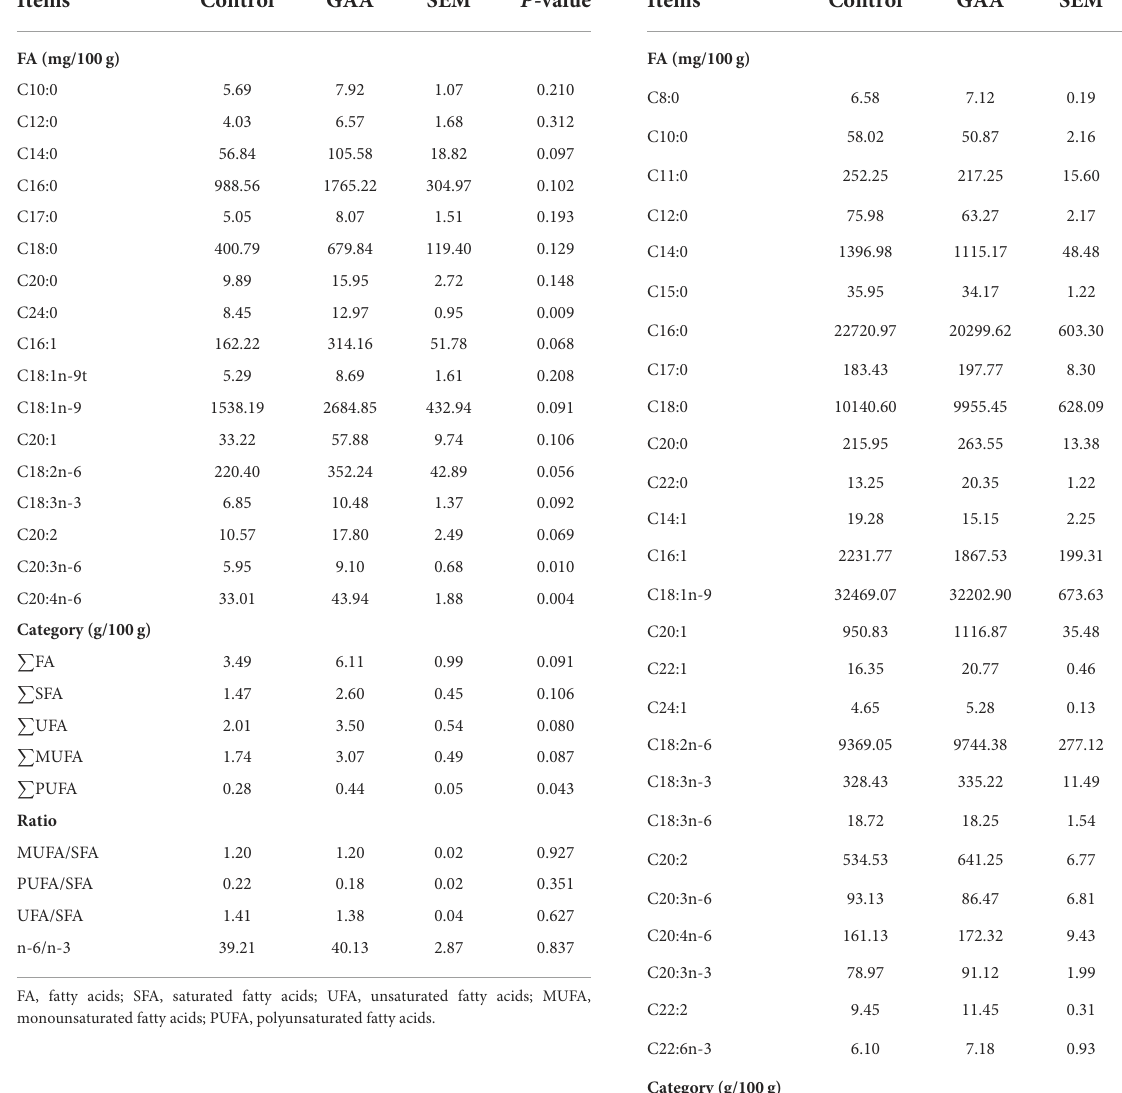
TABLE 6 Effect of dietary GAA on fatty acid contents of back fat in Tibetan pigs (based on wet weight). Items Control GAA SEM P -value FA